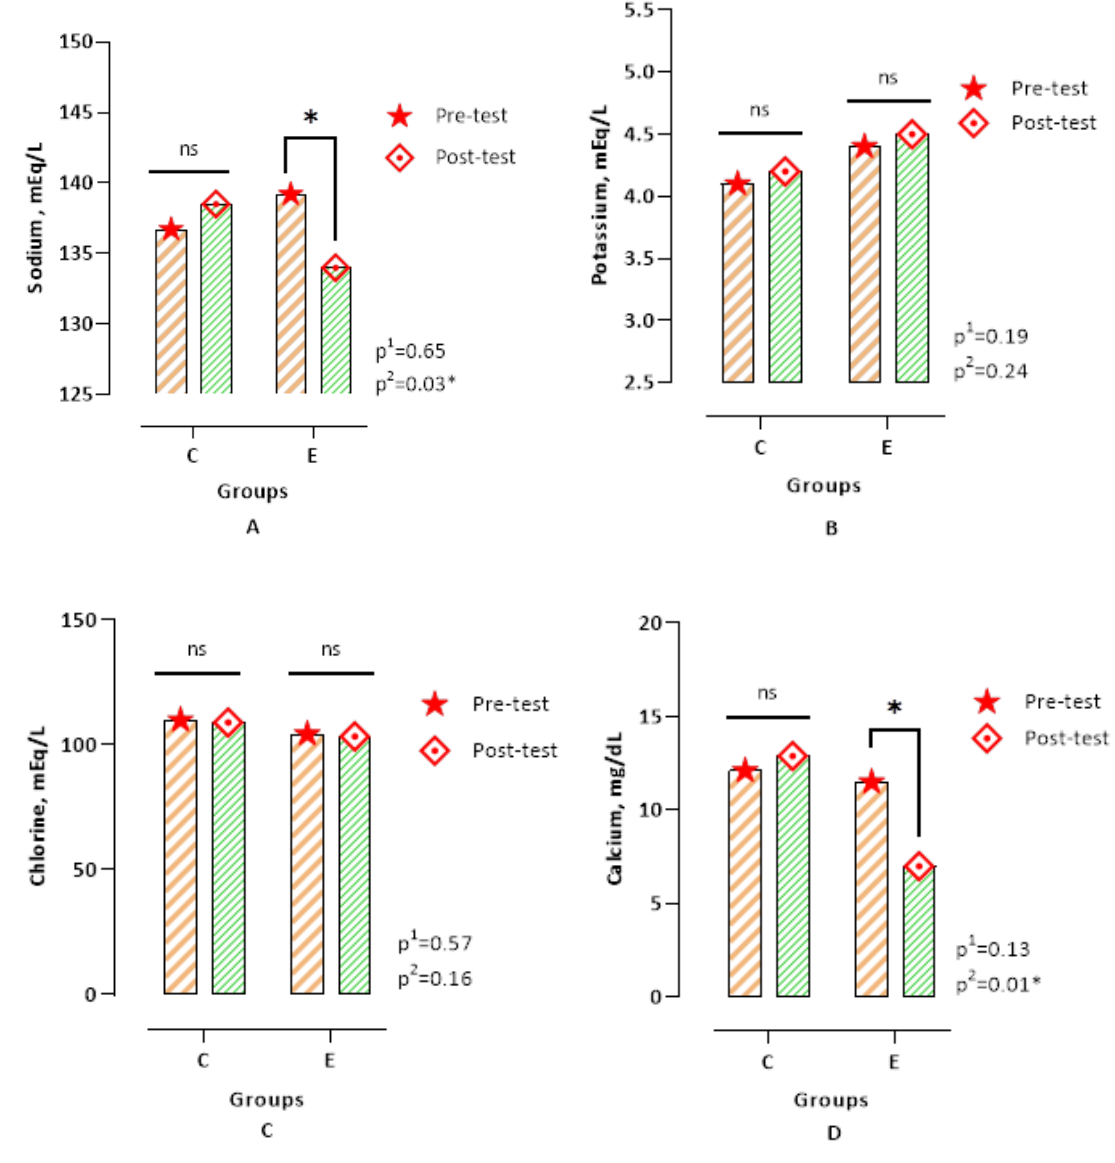
Figure 3. The figure below demonstrates the within-group pre-test/post-test serum elements sodium, potassium, chlorine and calcium (Experimental, Control;